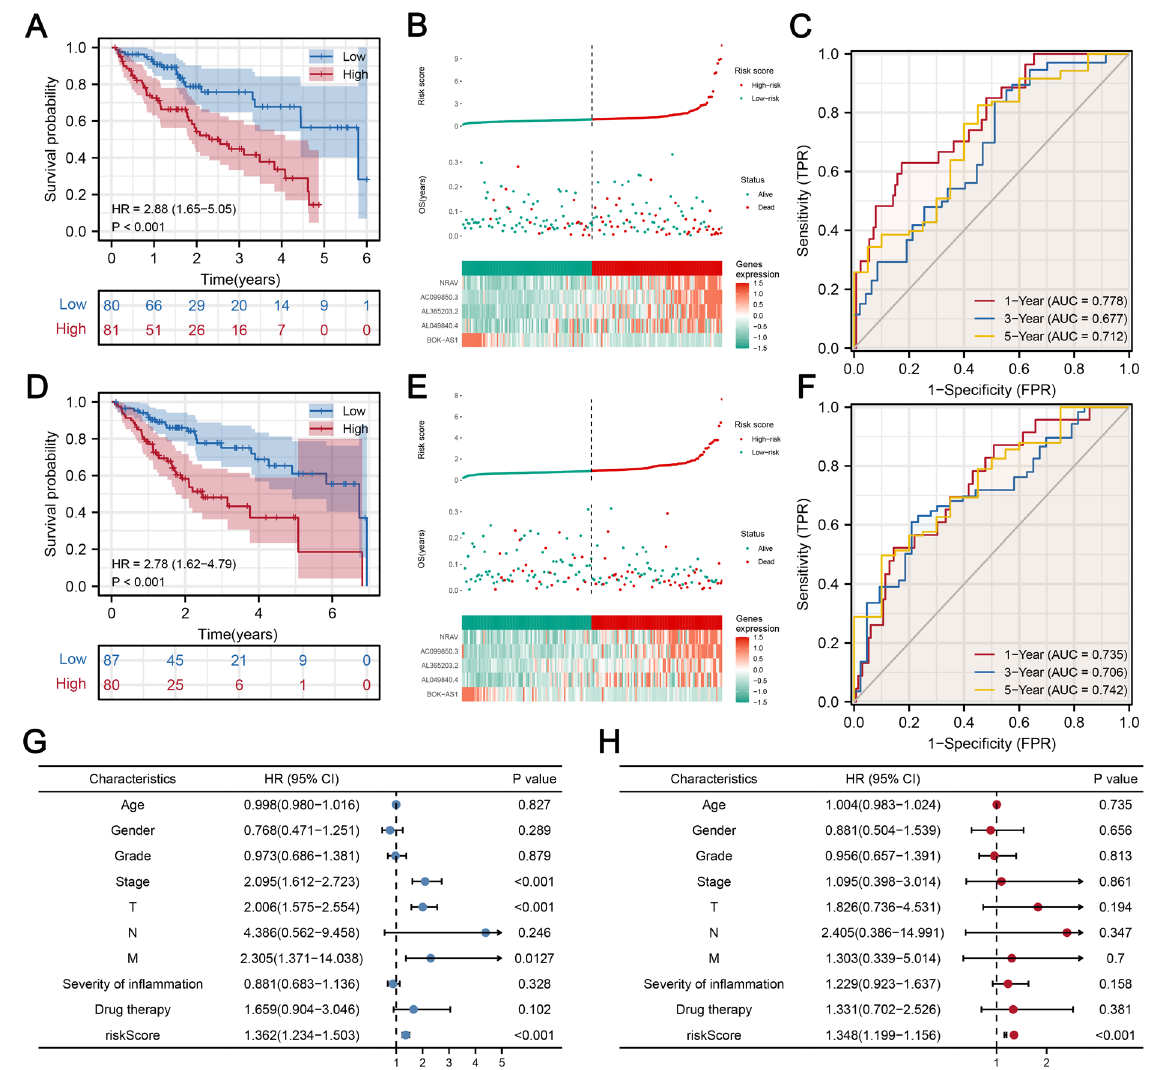
Figure 3. Evaluation and verification of the prognostic costimulatory molecule-related lncRNA signature. Kaplan–Meier survival curves for high- and low-risk patients in training (A) and testing (D) cohorts. Distribution and survival status of HCC patients with different risk scores. A heatmap showing the expression levels of five prognostic costimulatory molecule-related lncRNAs in the high- and low-risk groups in training (B) and testing (E) cohorts. Time-dependent ROC curves of the prognostic signature in training (C) and testing (F) cohorts. (G, H) Univariate and multivariate Cox regression analyses for the risk score as an independent prognostic